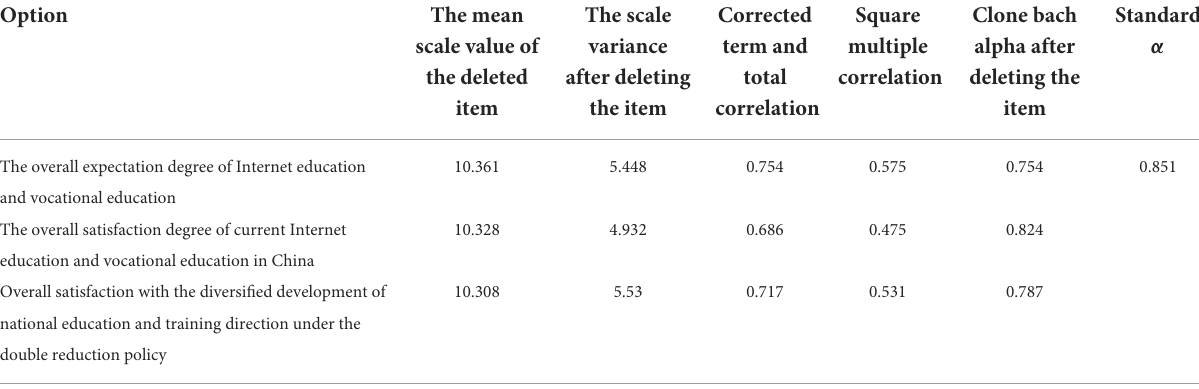
The scale Corrected